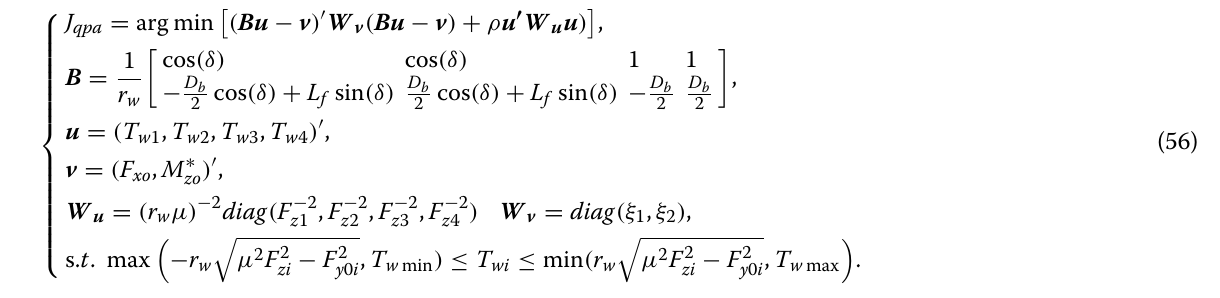
impact(See figure on next Figure 10 Vehicle motion and partial ghosts trail after the initial left-rear